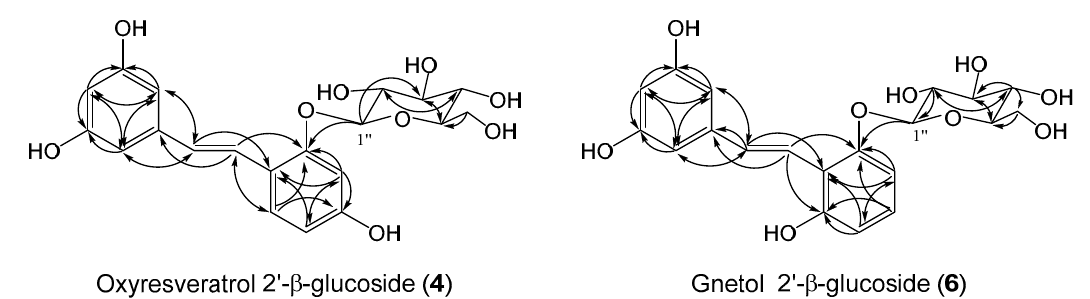
Figure 2. HMBC correlations of oxyresveratrol 2 ′ - β -glucoside ( 4 ) and gnetol 2 ′ - β -glucoside ( 6 ).